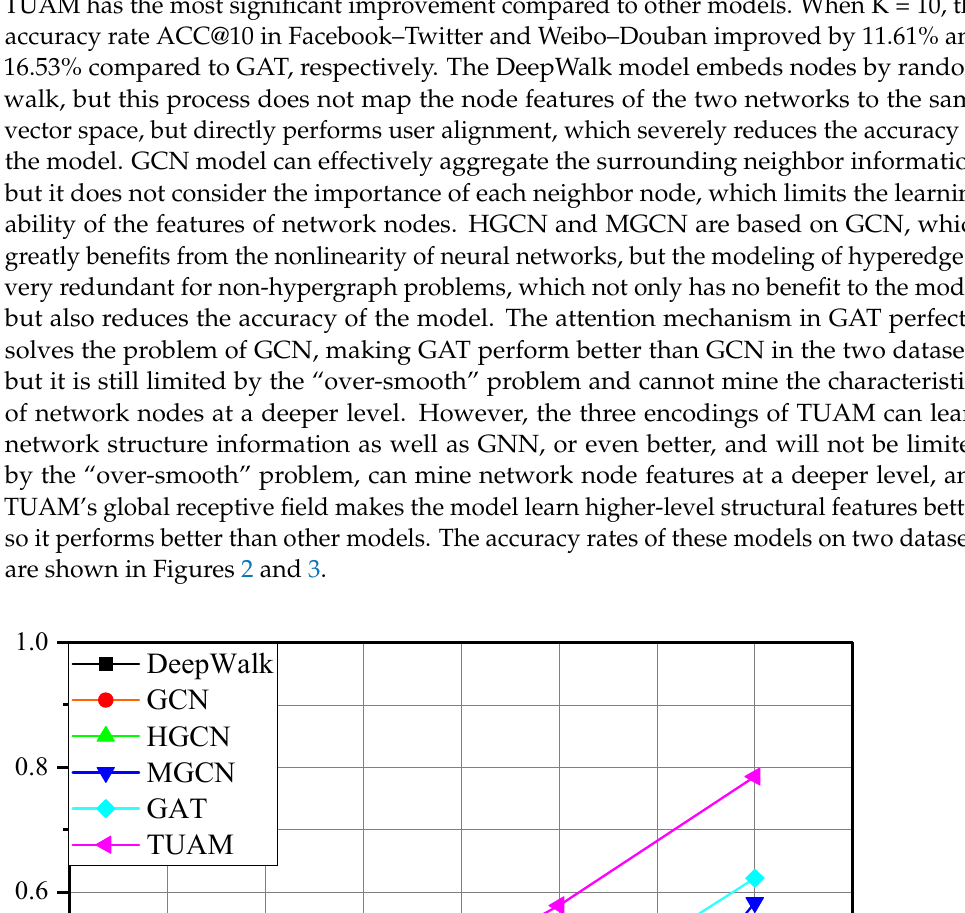
Figure 3. The accuracy of several models on the Weibo–Douban dataset. In Figures 2 and 3, it is obvious that the accuracy of TUAM on two datasets is higher than other existing models, especially when K = 50. The ablation experiments on the im- portance of the three encodings are conducted in TUAM across the Facebook–Twi tt er and the Weibo–Douban datasets. The ablation results are shown in Tables 4 and 5. The best results are indicated in bold font. Table 5. Ablation experiment results on the Facebook–Twi tt er dataset. Centrality Encoding Spatial Encoding Edge Encoding